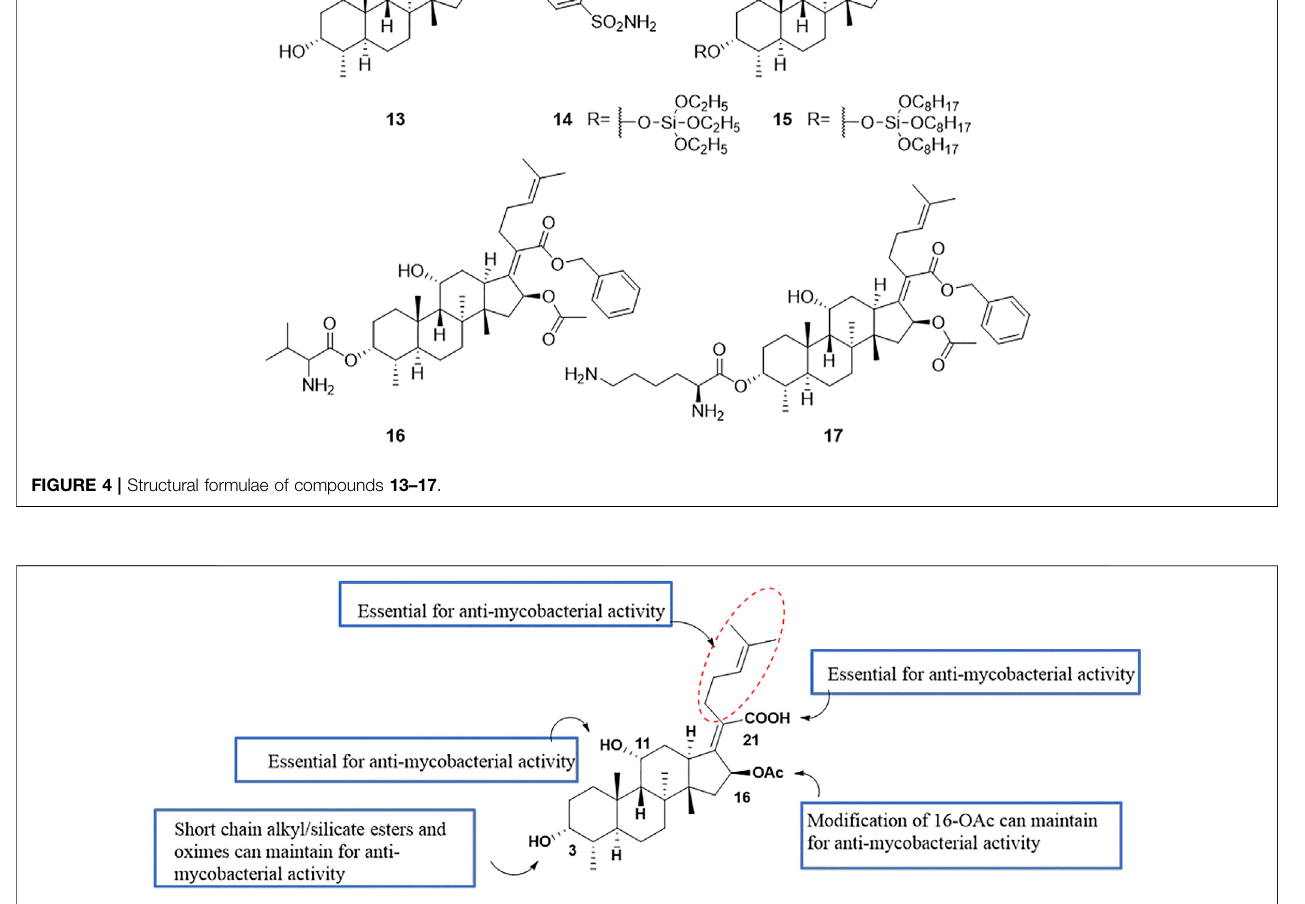
FIGURE 5 | SAR of the antituberculosis activity of